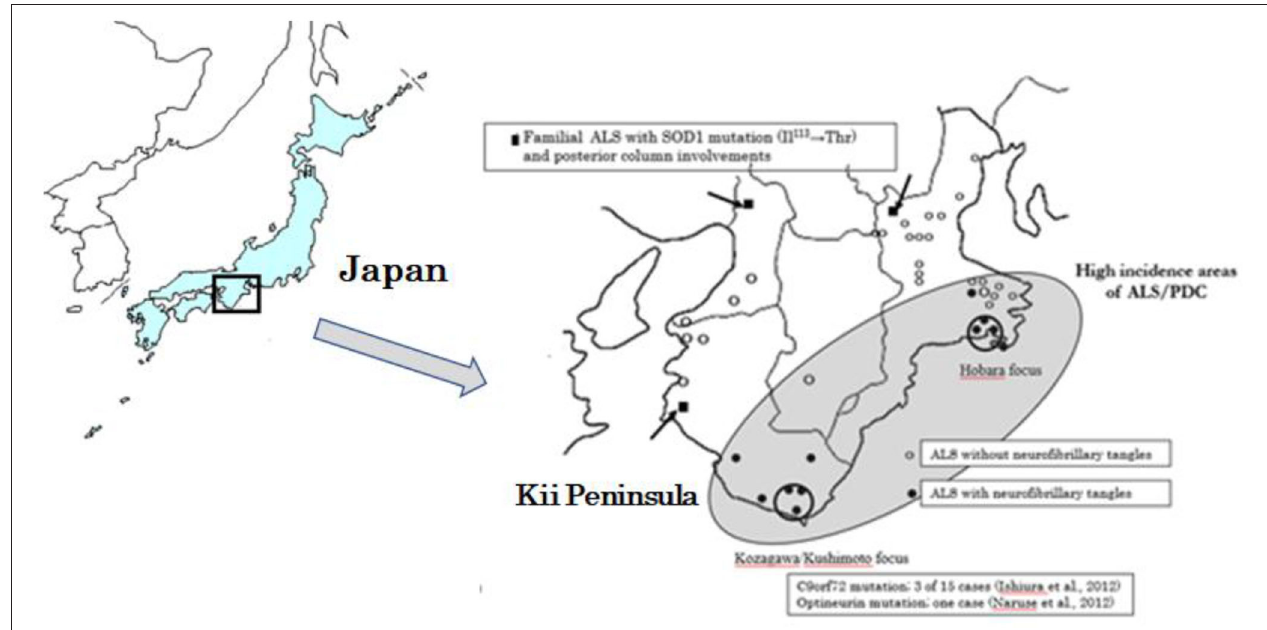
FIGURE 1 | Geographical distribution of ALS cases with neurofibrillary tangles, and with SOD1, C9orf97, and Optineurin gene mutations distributed in the Kii Peninsula of